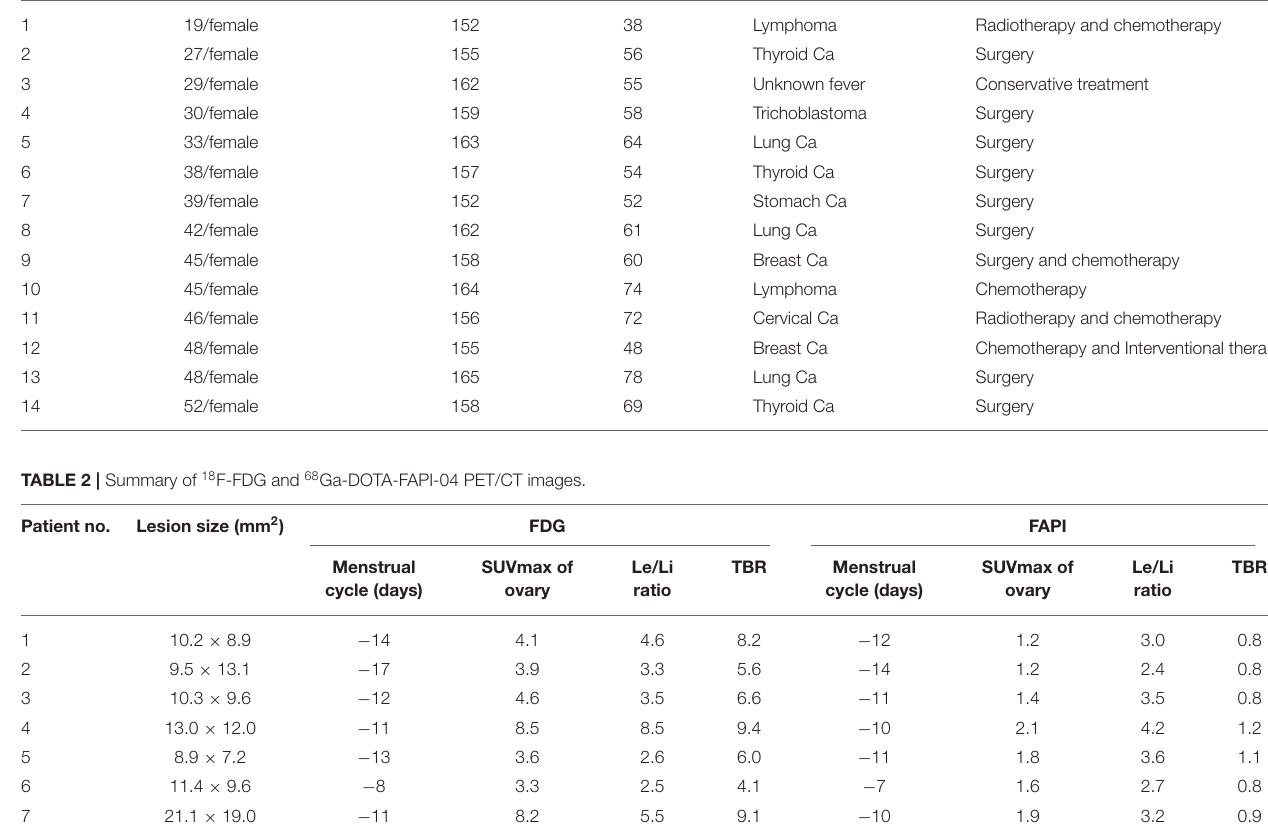
TABLE 1 | The demographic and clinical characteristics of patients. Patient no.